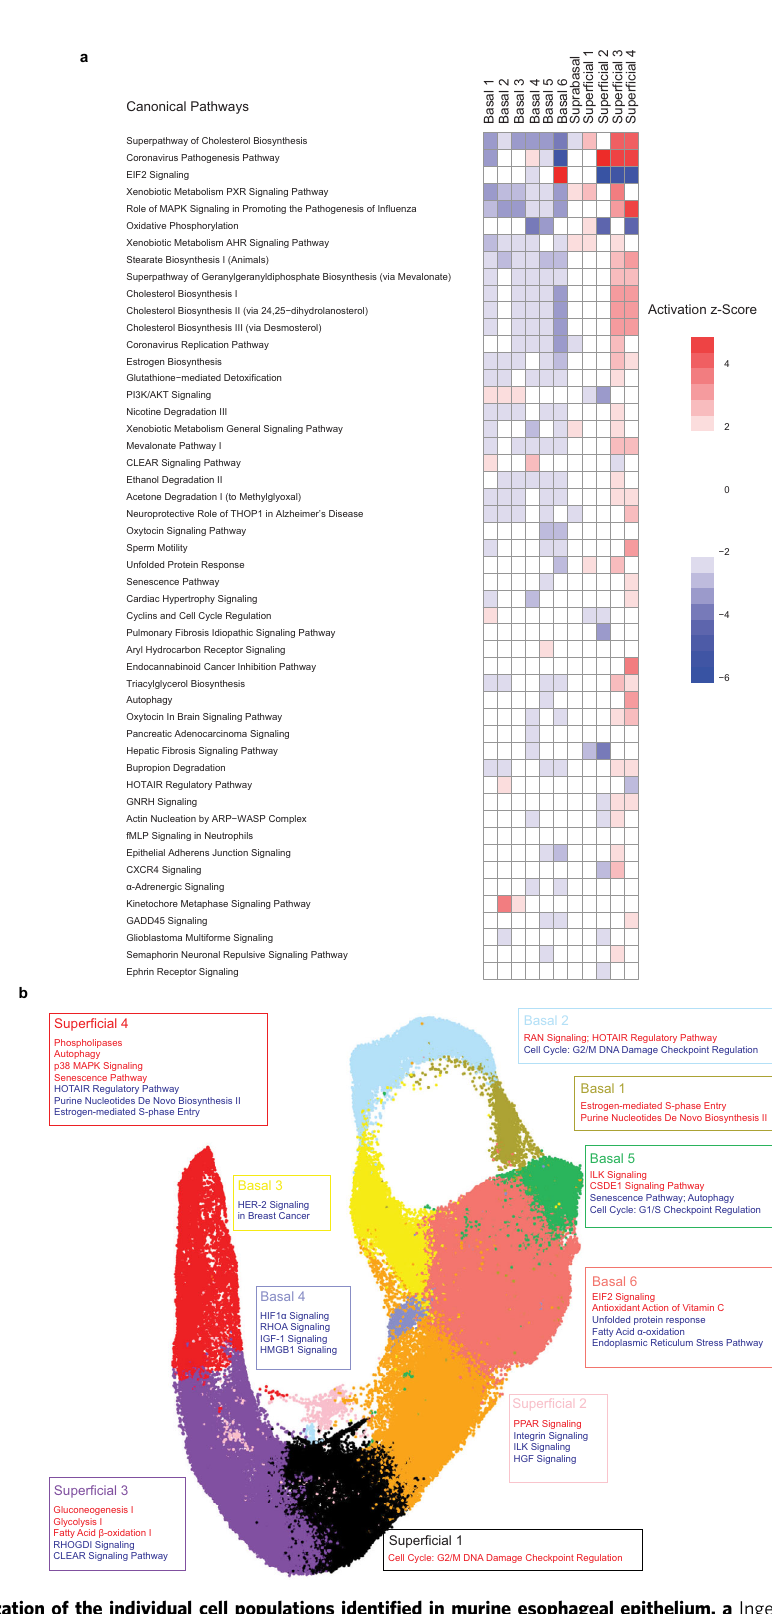
Fig. 3 Molecular characterization of the individual cell populations identi fi ed in murine esophageal epithelium. a Ingenuity pathway analysis (IPA) prediction of canonical pathways and their activation state in each cluster. In heat map, ranking is based upon activation z-score and color intensity depicts relative value of activation z-score. A positive value (red) indicates activation while a negative value (blue) indicates inhibition of the respective pathway. b Representative unique pathways identi fi ed by IPA in each population in murine esophageal epithelium along with their activation state. Source data are provided as a Source Data fi le. Source data are provided as a Source Data fi